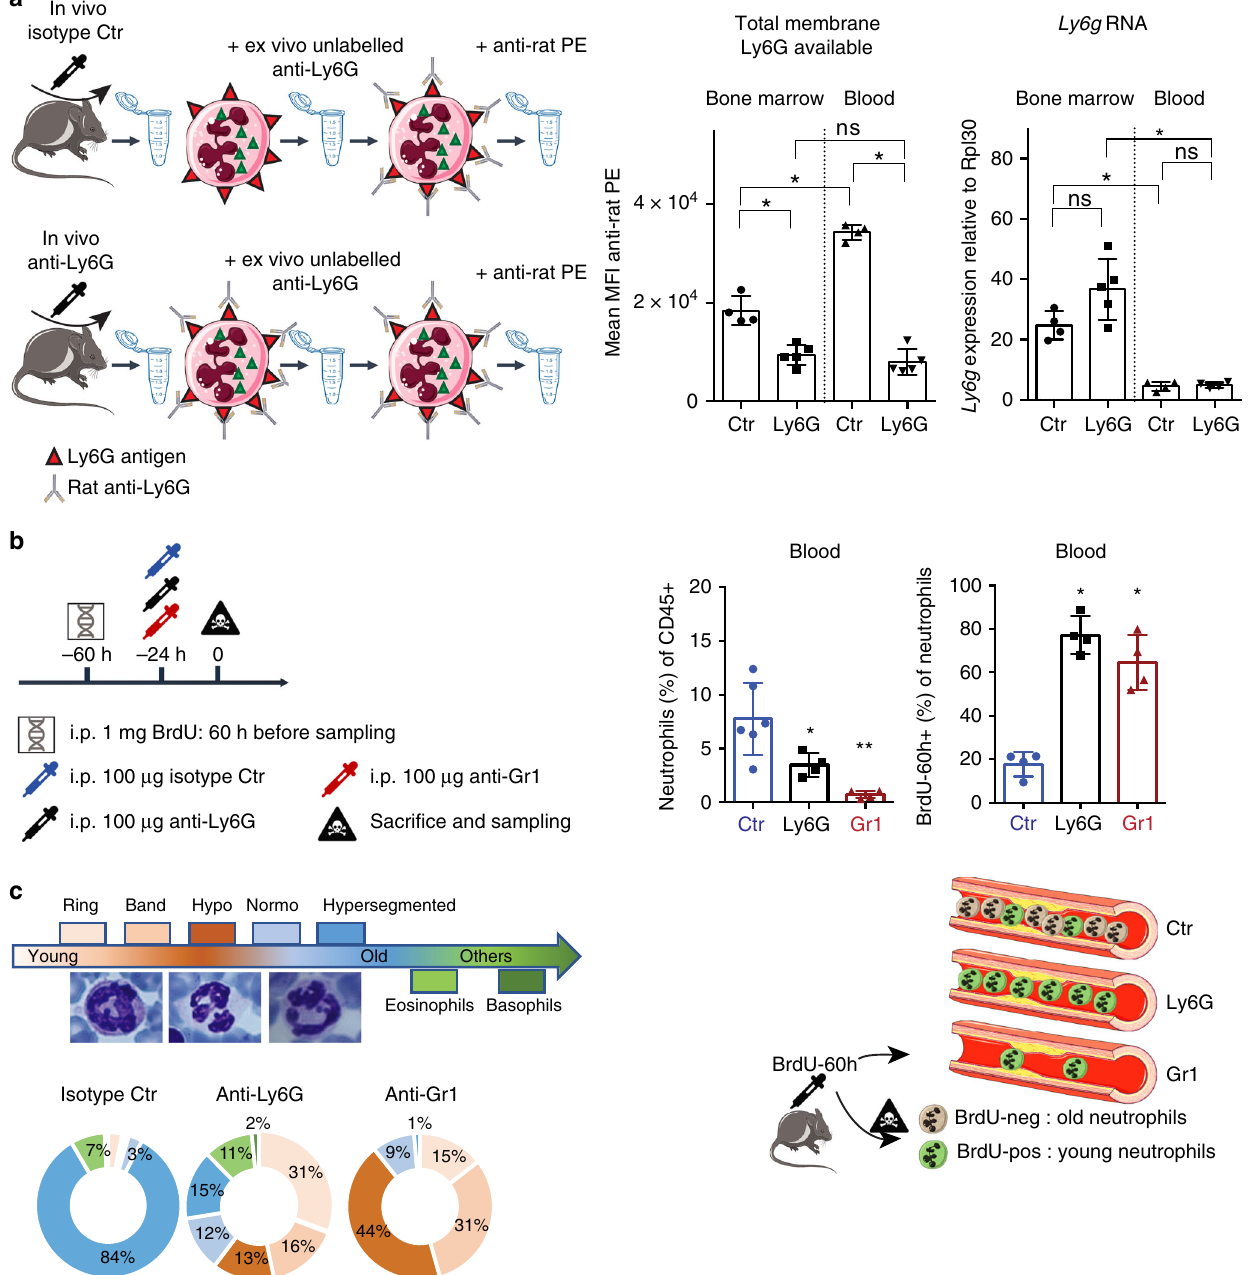
Fig. 2 Newly synthesized neutrophils upon anti-Ly6G have membrane Ly6G paucity. a Old (>20 weeks) C57BL/6 mice were treated with anti-Ly6G 50 μ g daily for 9 days. After sampling, bone marrow and blood cells were re-incubated with 10 μ g of anti-Ly6G to saturate the Ly6G antigen, and subsequently stained with a donkey anti-rat PE-labelled antibody to measure the whole amount of Ly6G antigen at the surface of neutrophils. MFI, mean fl uorescence intensity. RNA levels for Ly6g on puri fi ed neutrophils from the same mice is also shown in the right panel. n = 4 control (Ctr) and 5 anti-Ly6G mice. b (left) Setting for experiments performed on C57BL/6 mice of >20 weeks. (right) Prevalence of CD45 + CD11b + Ly6G intra + neutrophils among total CD45 + immune cells and their respective BrdU-60h incorporation. c Neutrophil segmentation, which correlates with neutrophil aging, was analyzed on Giemsa-stained blood smears. n = 5 control (Ctr) and 4 treated mice. All the results from ( b , c ) were acquired from the same blood samples. * p < 0.05, from Mann – Whitney test; error bars represent s.d. Source data are provided as a Source Data fi